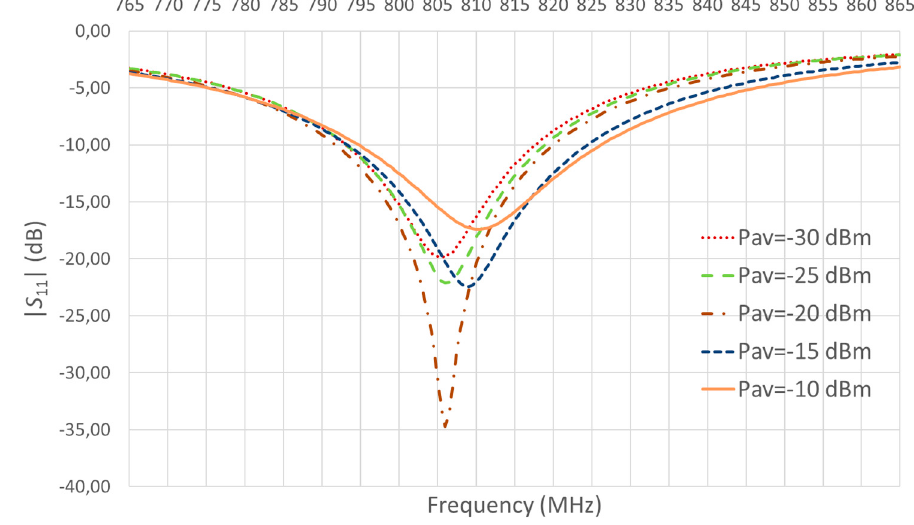
Figure 9. Experimental results of | S 11 |for different power levels.